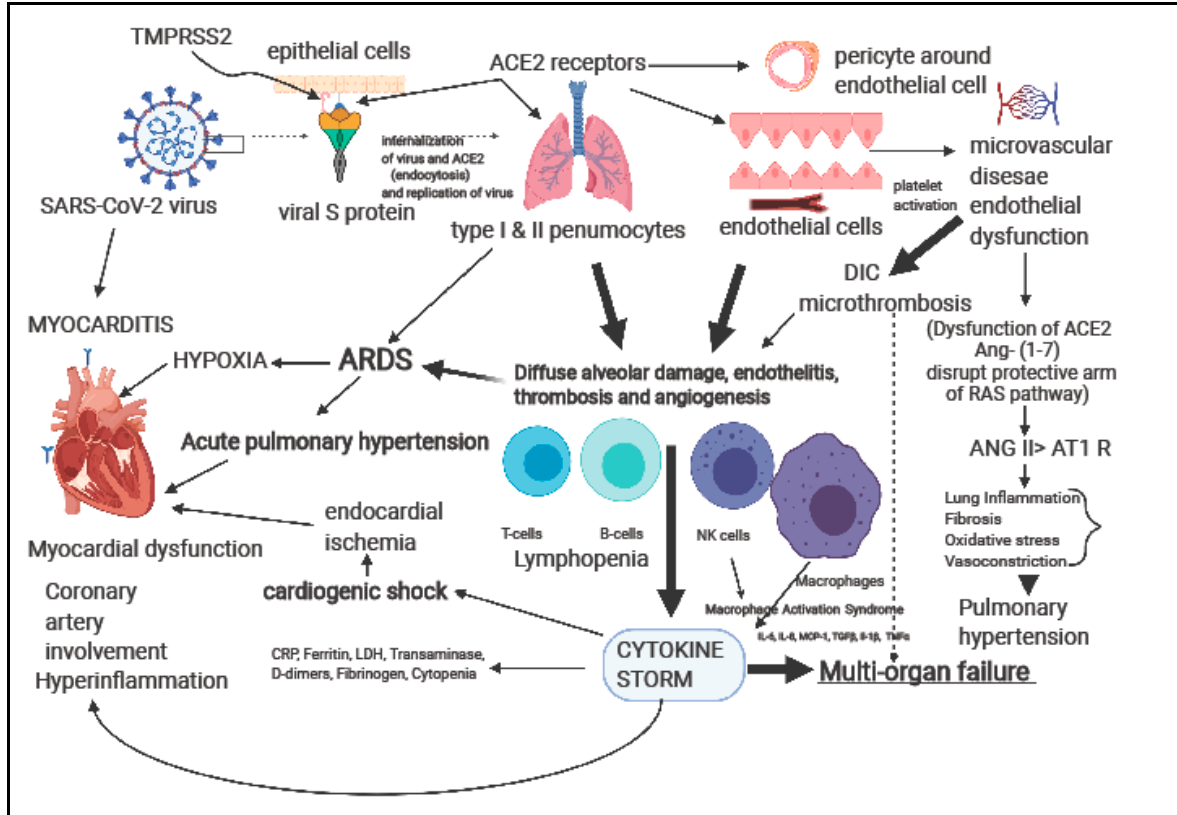
Figure 3. Several putative mechanisms of myocardial injury in early and late-COVID-19 illness. (Ang: Angiotensin; AT1 R: Angiotensin 1 receptor; ACE2: Angiotensin-Converting Enzyme; ARDS: acute respiratory disease syndrome; CRP: C-reactive protein; DIC: Disseminated intravascular coagulation; IL: Interleukin; LDH: lactate dehydrogenase; NK cells: natural killer cells; RAS: Renin-Angiotensin-System; TMPRSS2: transmembrane serine protease 2) (Created with biorender.com).